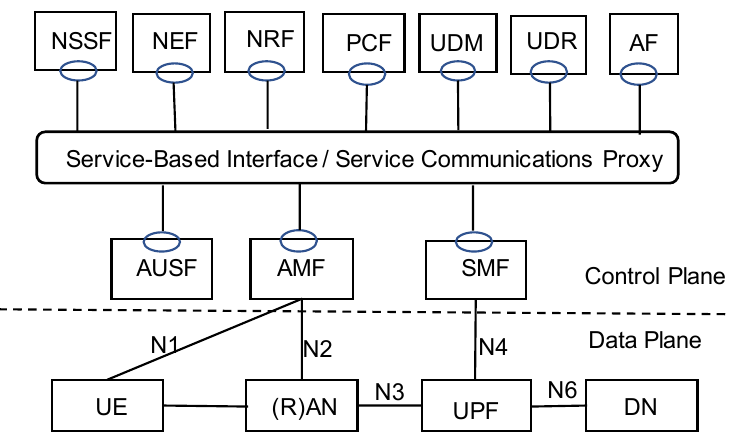
Figure 1. The Service-Based Architecture (SBA) for the 5G